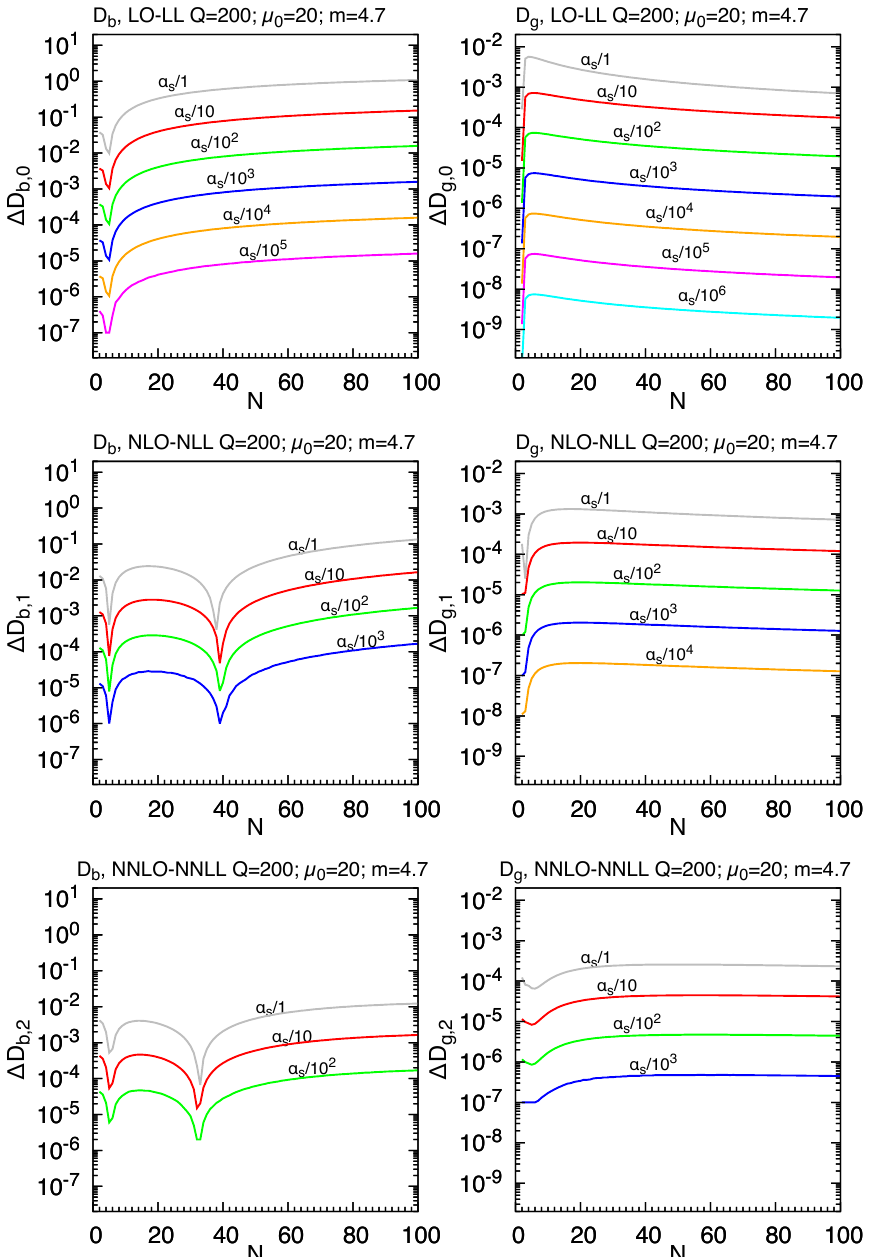
Figure 9 . The scaling of the di(cid:11)erence (cid:1) D p;q , de(cid:12)ned in eq. (A.7), w.r.t. (cid:11) s , for p = b; g (left, right) and q = 0 ; 1 ; 2 (top, medium and bottom